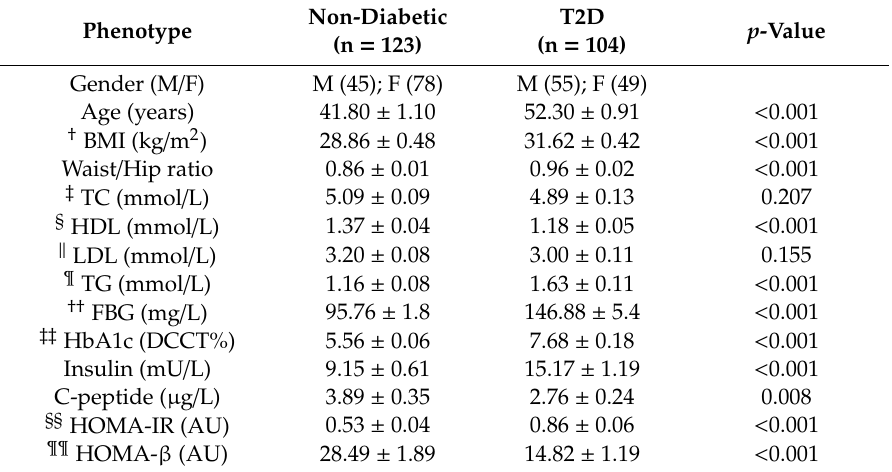
Table 1. Characteristics of non-diabetic and type 2 diabetic (T2D) study subjects.